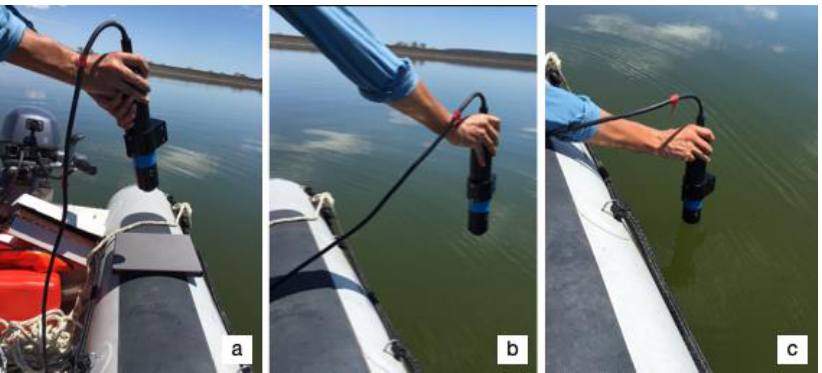
Figure 3. Deployment of the Satlantic spectroradiometer at Lake Dyer. Three sets of successive measurements were taken ( a ) over the calibrated grey panel, ( b ) over the water surface and ( c ) just below the surface.